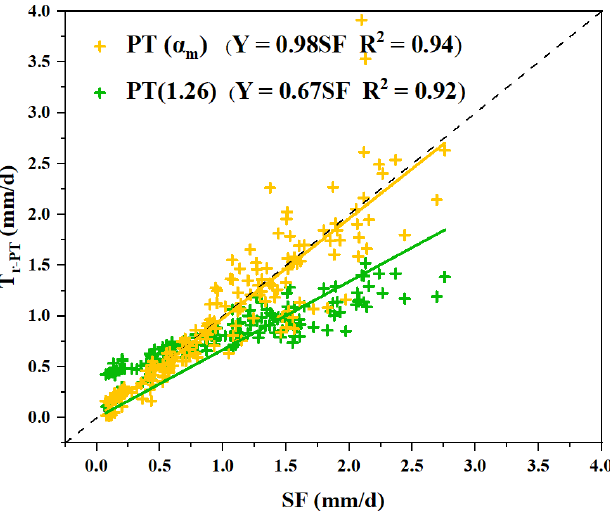
Figure 5. Correlation between simulated daily transpiration (T r-PT ) by the PT model using the original coefficient α of 1.26 (PT( α = 1.26)) and the calibrated α using Equation (28) and the measured daily sap flow (SF) during the three winter seasons.